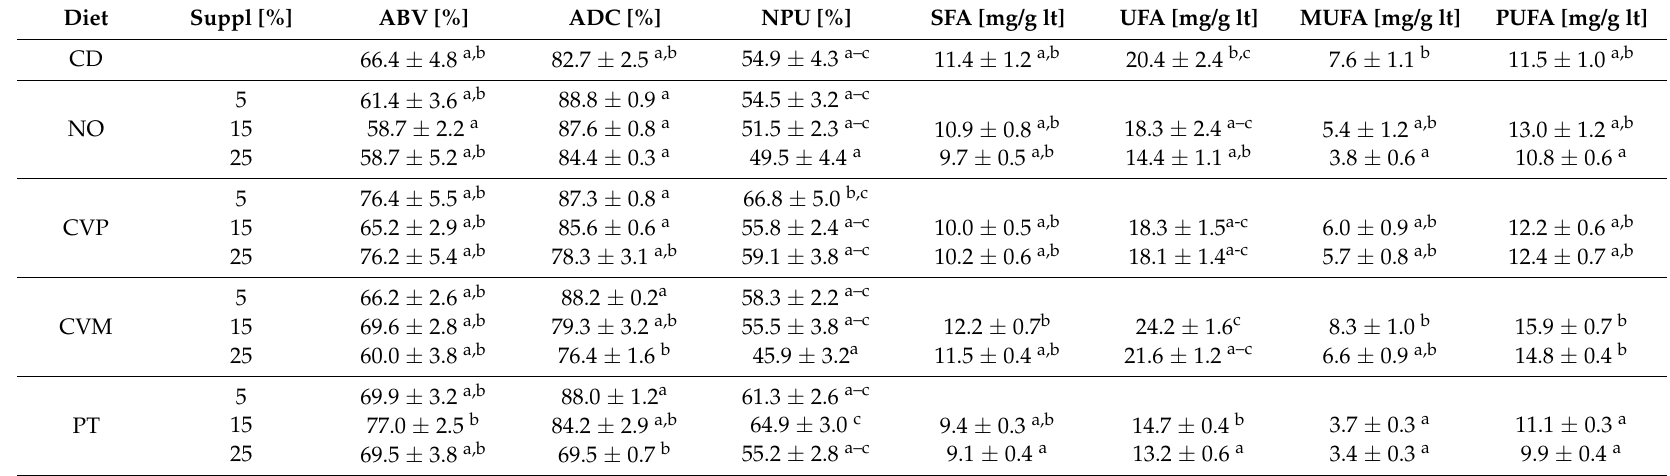
Means with different letters mark significant differences (ANOVA followed by Dunnett’s T3 post hoc test for ABV, ADC and PUFA or Tukey post hoc test, p < 0.05); Abbreviations: control diet (CD), N. oceanica (NO), C. vulgaris phototrophic cultured (CVP), mixotrophic cultured (CVM), P. tricornutum (PT), supplementation (Suppl), apparent biological value (ABV), apparent digestibility coefficient (ADC), net protein utilization (NPU), saturated fatty acids (SFA), liver tissue (lt), unsaturated fatty acids (UFA), monounsaturated fatty acids (MUFA), polyunsaturated fatty acids